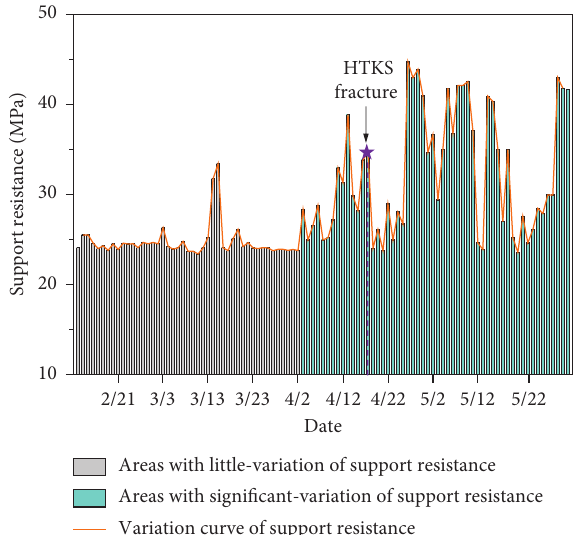
Figure 1: Variation curve of working resistance of typical support marked as 11#.